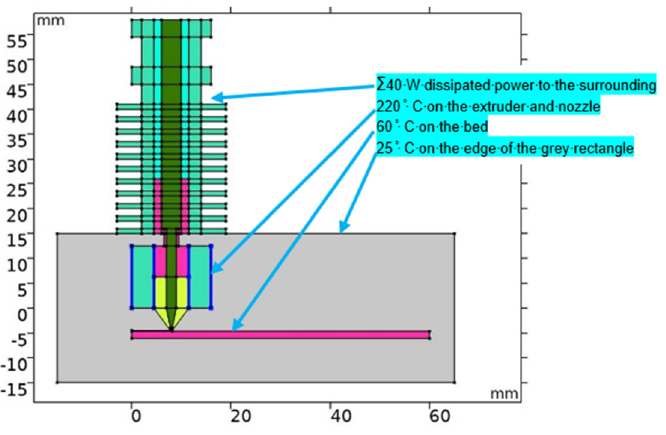
Figure 1. Geometry of the static model with boundary conditions.